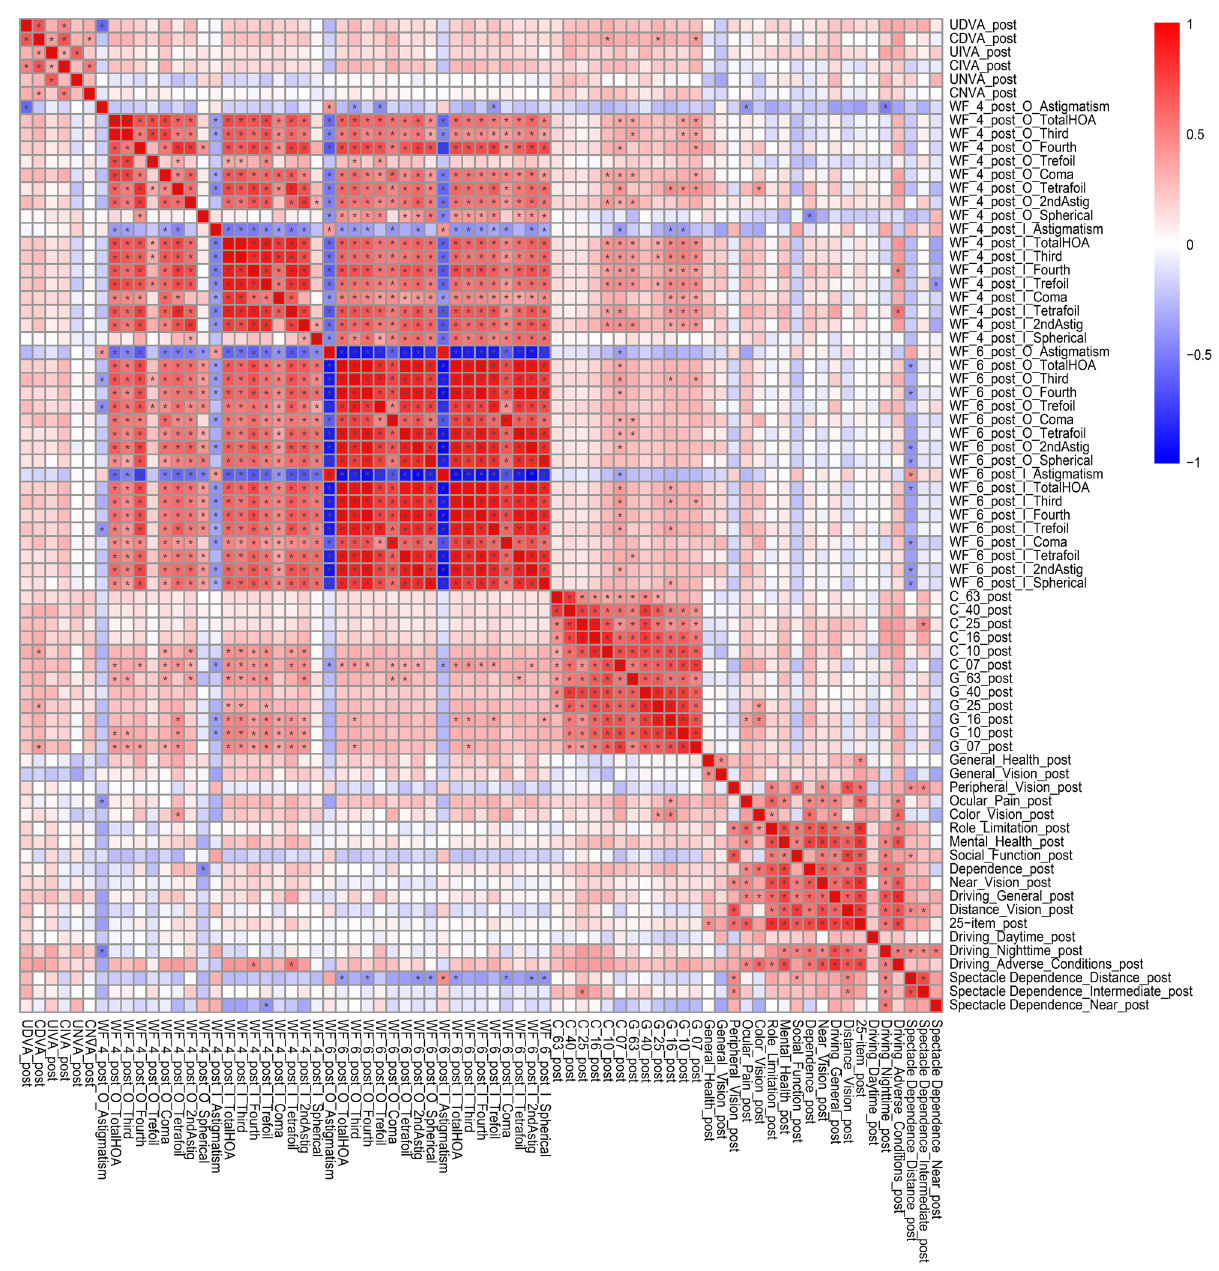
Figure 5. Heatmap of Pearson’s correlation coefficients between all possible combinations of variables, which were adjusted by multiple regression with the explanatory variables in Table 1, in the rotationally asymmetric refractive (Lentis Comfort LS-313 MF15) group. The asterisk * in this figure indicates a significant correlation between two parameters at p < 0.00002 after Bonferroni’s correction. The two-sided t test was applied to evaluate the significance of differences between the two groups. The sample size for each parameter is shown in Supplementary Table S4(C). The illustration was performed using a commercially available software program (R, version 3.6.1; R Core Team, 2019, Vienna, Austria) 49 (https:// cran.r- proje ct. org/ web/ packa ges/ pheat map/ pheat map.